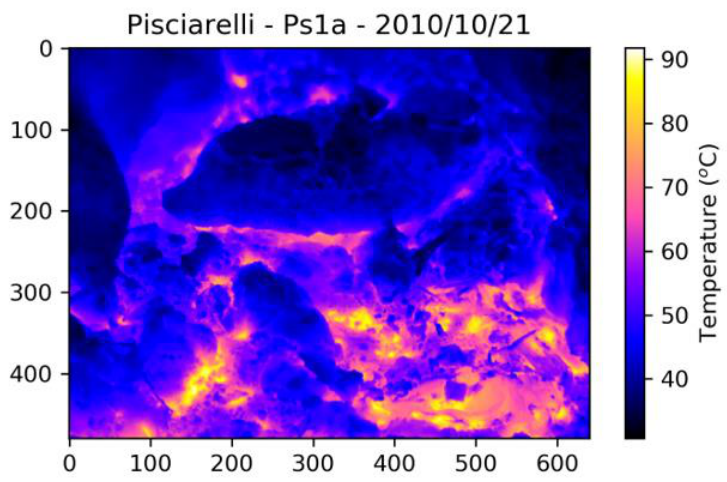
Figure 9. Example of thermal image of the station Ps1a at the Pisciarelli area (Campi Flegrei), indicated as “Ps1a” in Figure 1.